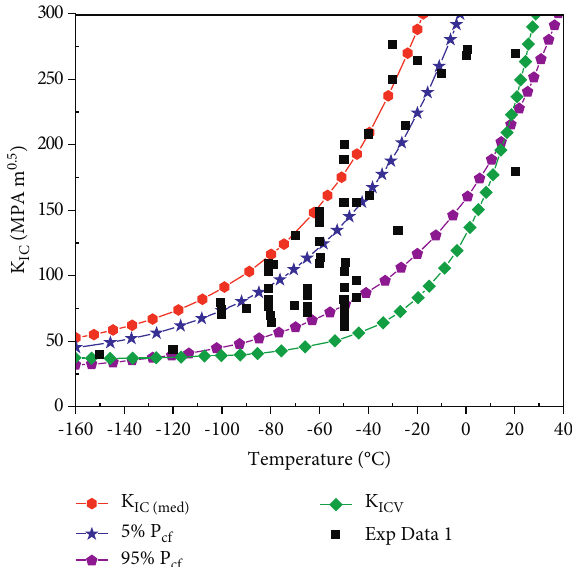
Figure 15: Fracture toughness curve generated by MC approach using fracture toughness Exp Data 1, T 0 �− 68.6 ° C, and 5% and 95% RPV material failure